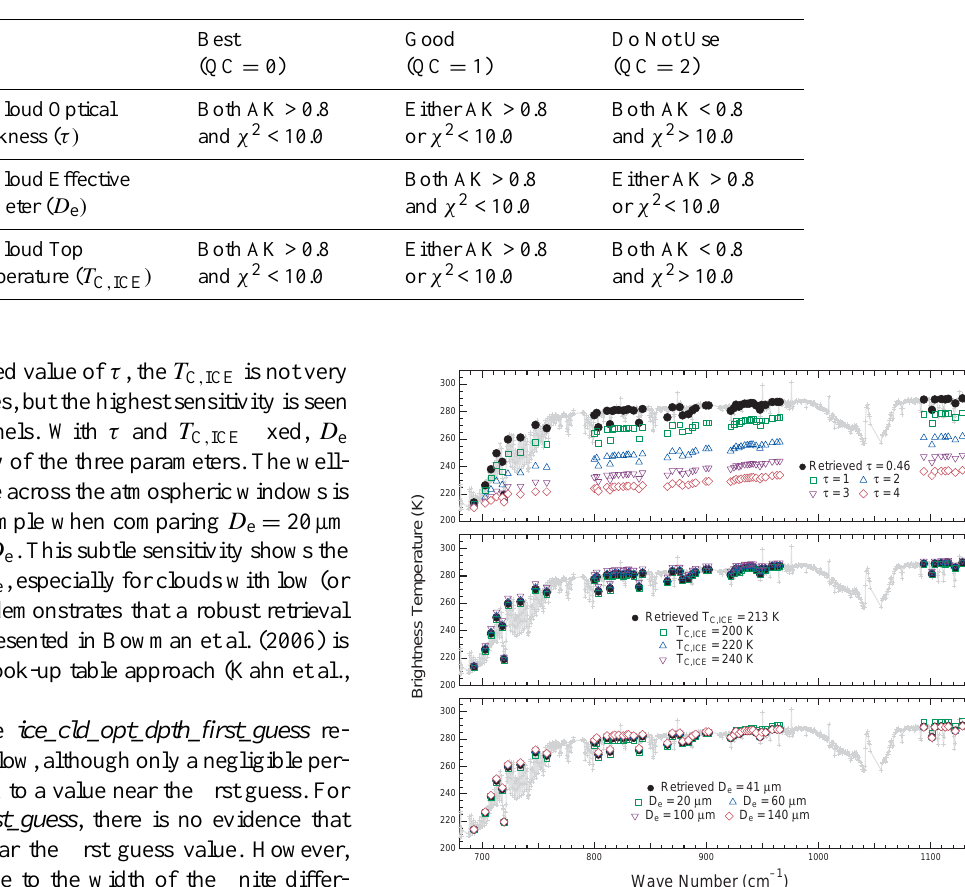
Table 2. Listed is the quality control (QC) determination for the three ice cloud retrieval parameters. The scalar averaging kernels (AK) are for each parameter and the value of χ 2 is the measure of fit between the observed and simulated radiances. The QC indicators are neither absolute nor quantitative. The variables ice_cld_fit_reduced_chisq ( χ 2 ) , ice_cld_opt_dpth_ave_kern (AK for τ) , ice_cld_eff_diam_ave_kern